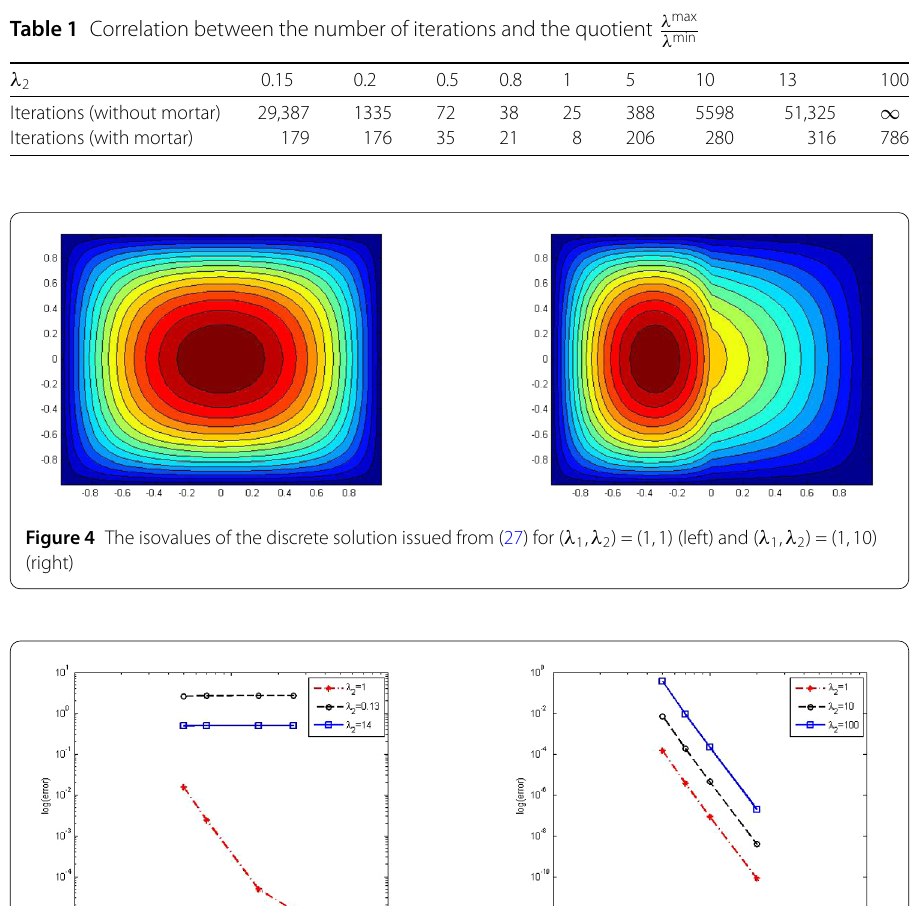
Table 1 Correlation between the number of iterations and the quotient λ max